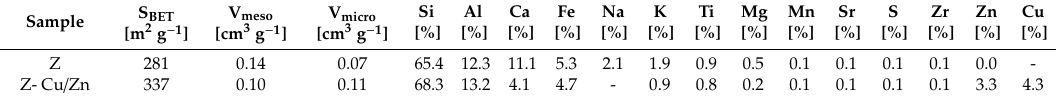
Table 1. Physical and chemical characteristics of natural and modified zeolite samples 1